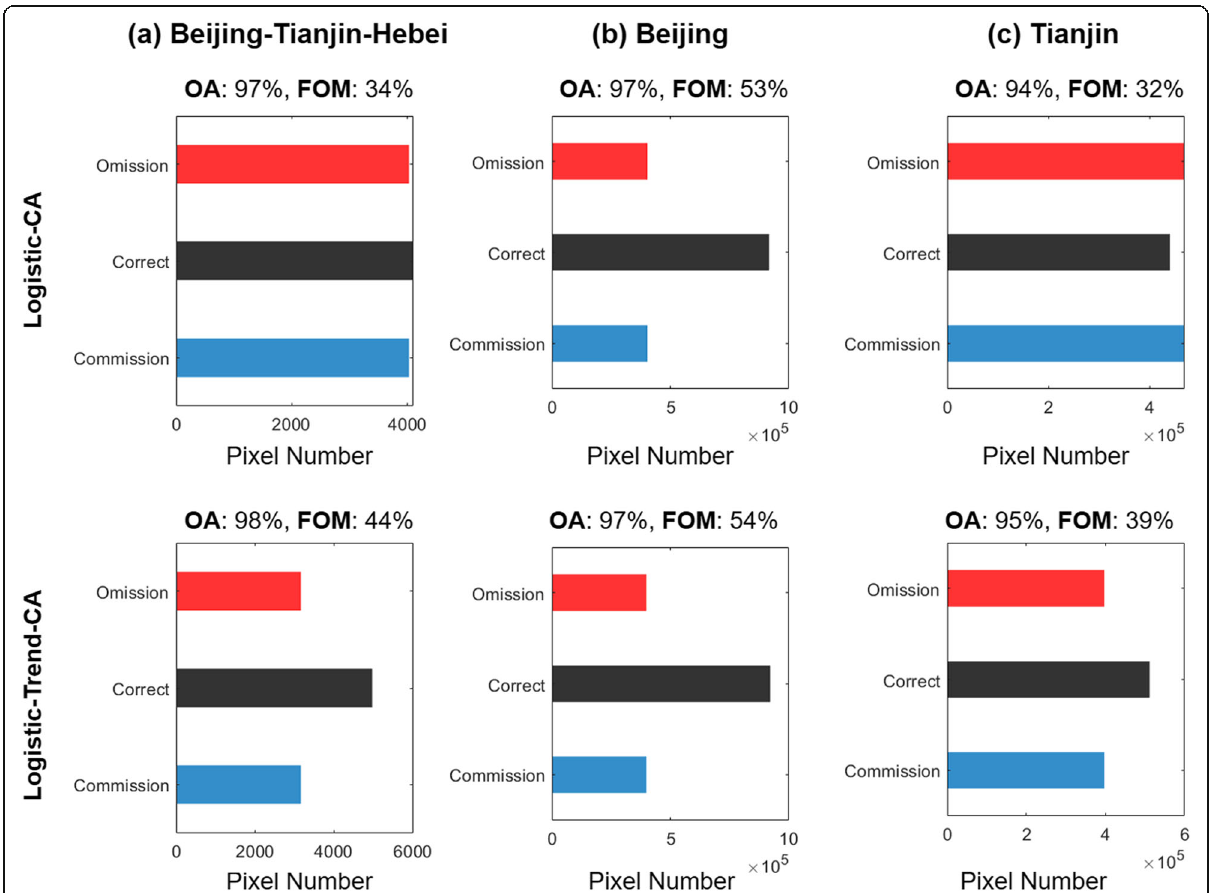
Fig. 8 Assessment of model performance in the Beijing-Tianjin-Hebei region at the 1-km spatial resolution from 2002 to 2013 ( a ) and in Beijing ( b ) and Tianjin ( c ) at the 30-m spatial resolution from 2005 to 2015